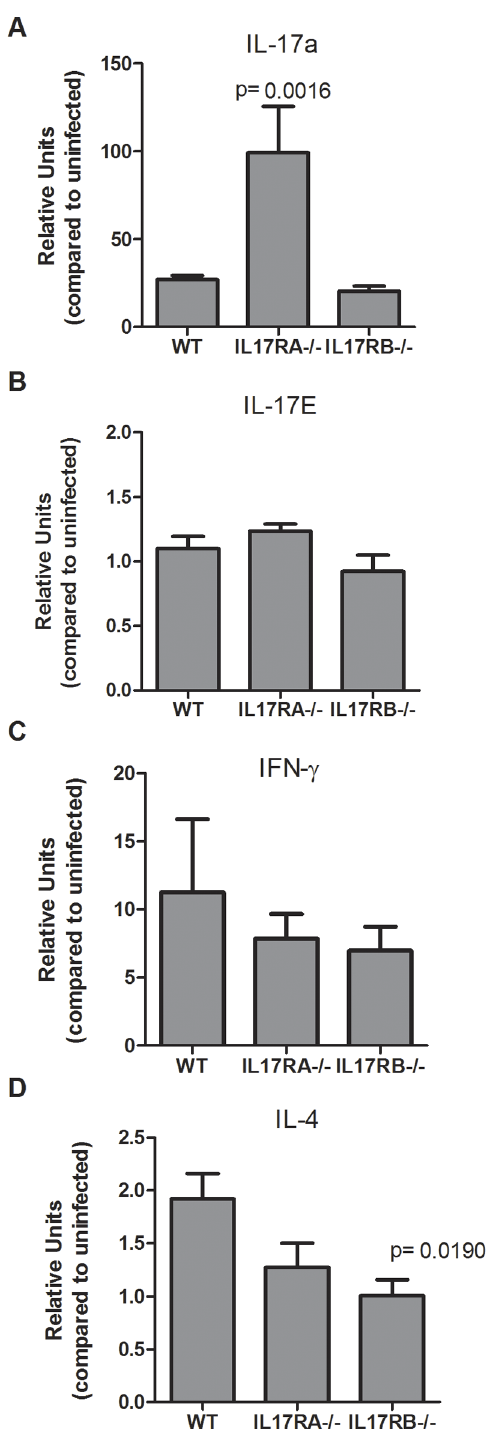
Figure 4. T helper cell cytokine expression is affected by IL-17R deficiencies. Real time rtPCR was performed on stomach tissue of H. pylori (strain SS1)- infected mice. Relative units of IL-17A (A), IL-17E (B), IFN c (C) and IL-4 (D) were measured at 3 months post-infection. Relative units also known as normalized expression are a measure of the relative expression calibrated to expression in uninfected wild-type mice using GAPDH as the endogenous control. Each time point represents 5–6 mice per group.